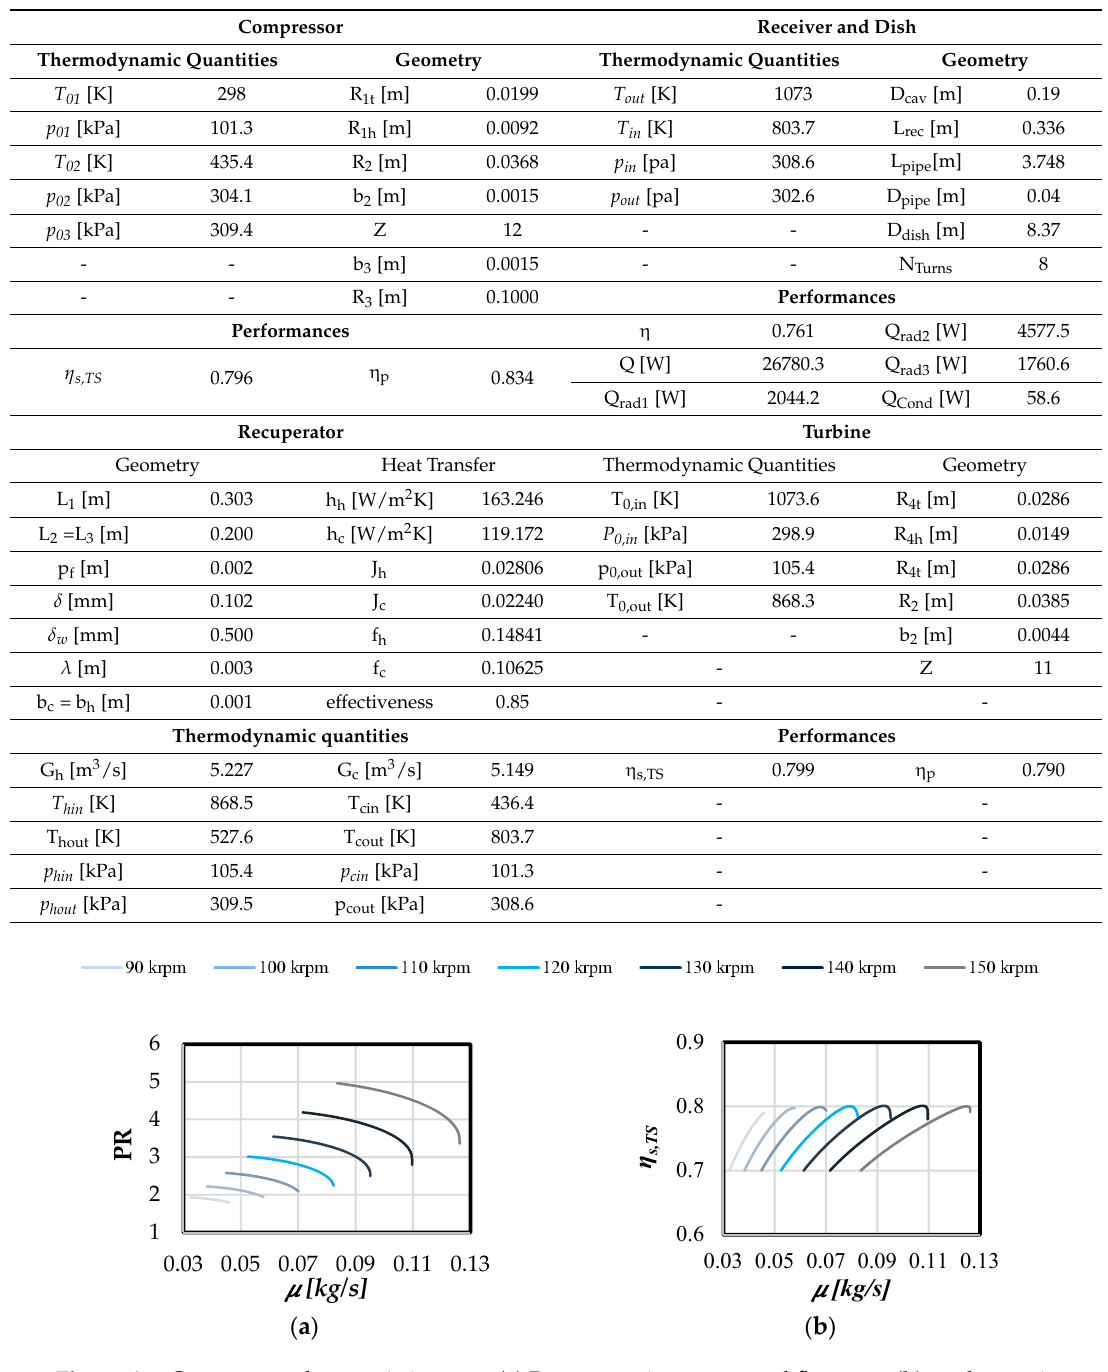
Figure A1. Compressor characteristic maps. ( a ) Pressure ratio vs corrected flow rate; ( b ) total to static isentropic efficiency vs corrected flow rate.